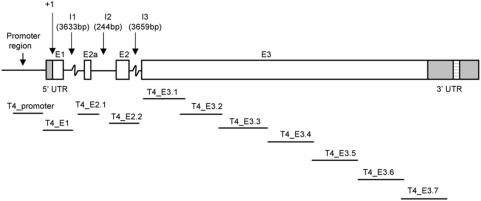

TLR4 gene structure and fragment design for dHPLC.E1, E2, E3 denotes exons 1, 2, and 3. E2a denotes an alternative exon 2. I1, I2, I3 denotes intronic sequences. 5′UTR and 3′UTR represent the untranslated regions. The lines underneath the gene structure show the approximate positions of the 11 fragments designed for mutation detection by dHPLC. The names of each fragment are above the lines.